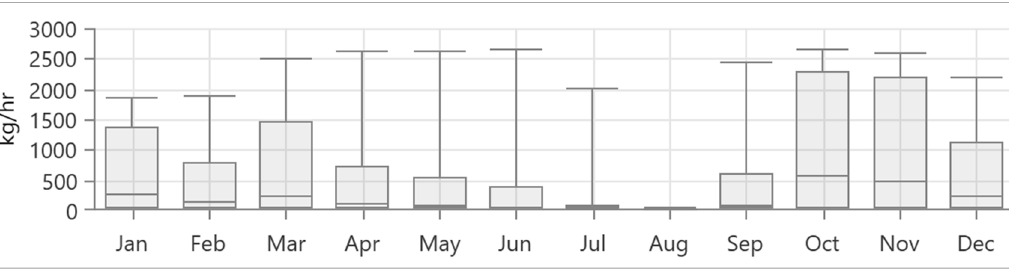
Figure 14. Monthly average hydrogen consumption. Table 6. Comparison between the base system and the other systems.